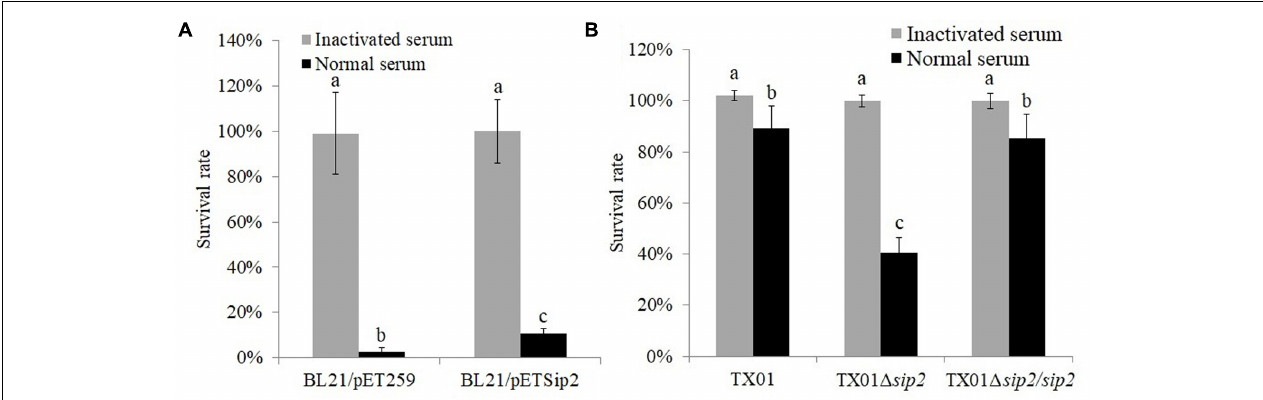
FIGURE 1 | Effect of Sip2 on bacterial resistance against serum damage. (A) Escherichia coli BL21/pETSip2 (expressing Sip2) and BL21/pET259 (control) were treated with normal or inactivated tongue sole serum for 1 h, and bacterial survival was determined. (B) Edwardsiella tarda TX01, TX01 (cid:49) sip2 , and TX01 (cid:49) sip2 / sip2 were treated with tongue sole serum as above, and bacterial survival rate was determined. Data are the means of three independent experiments and presented as means ± SEM. Values with different letters indicate significantly different ( P < 0.05).